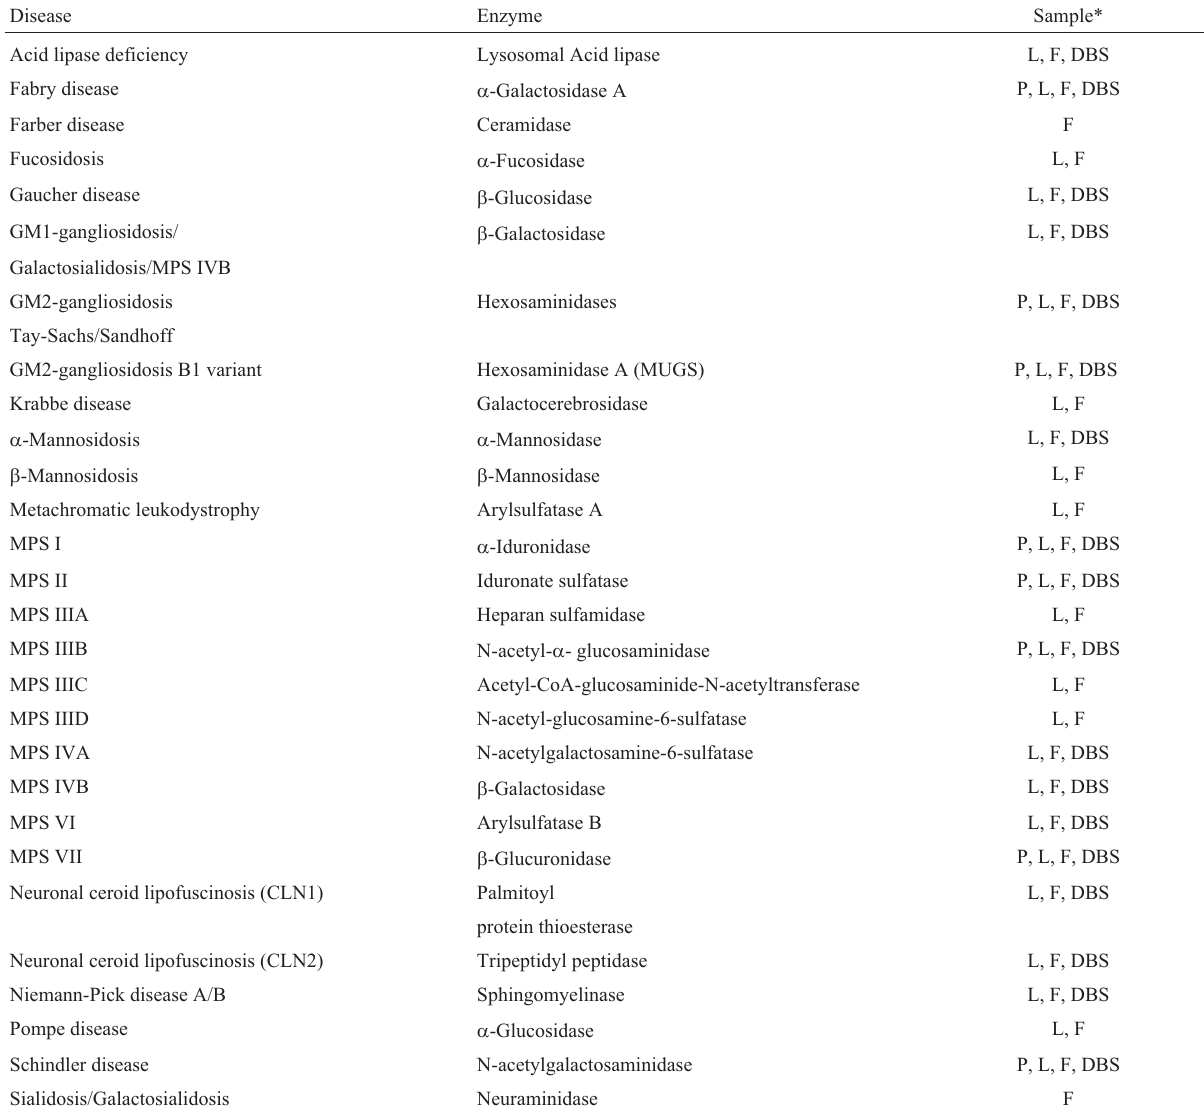
Table 1 - Specific enzyme assays performed for the diagnosis of LSDs in MGS/HCPA.